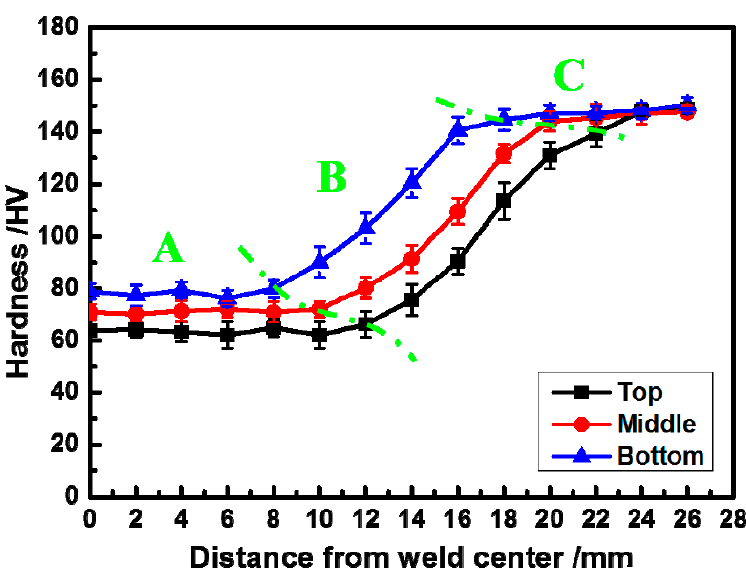
Figure 8. Typical hardness profiles across the weld of an friction stir welding (FSW)